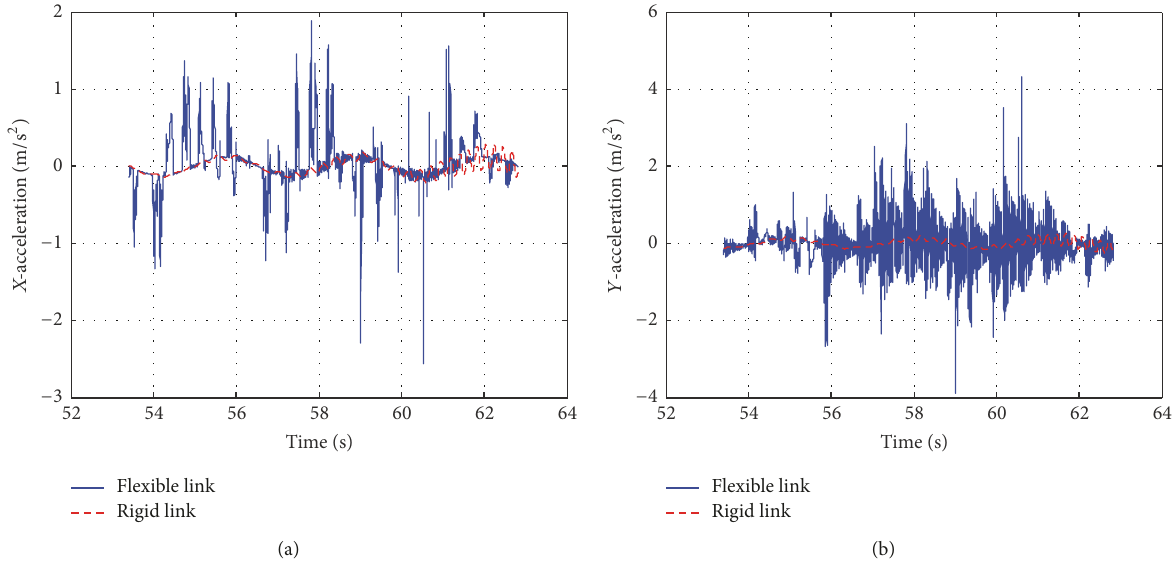
Figure 10: Acceleration diagram of the moving platform: (a) acceleration in 𝑋 direction; (b) acceleration in 𝑌 direction.